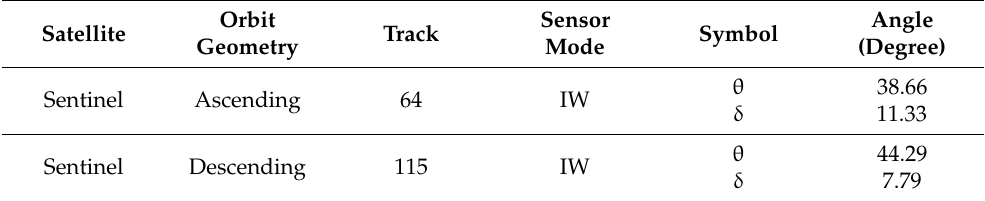
Table 2. Satellite viewing (LOS) angles for the Sentinel and Radarsat-2